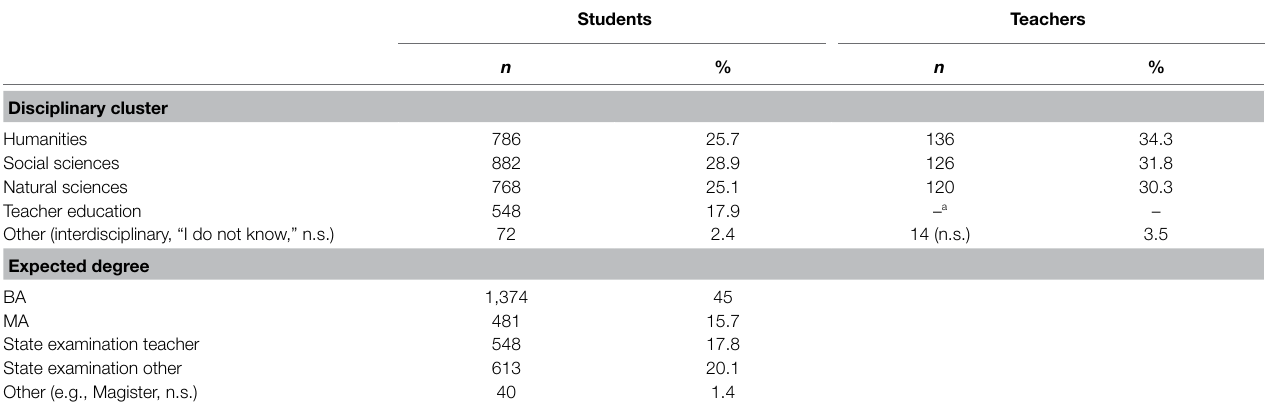
TABLE 1 | Student and teacher samples by disciplinary cluster and expected degree (for